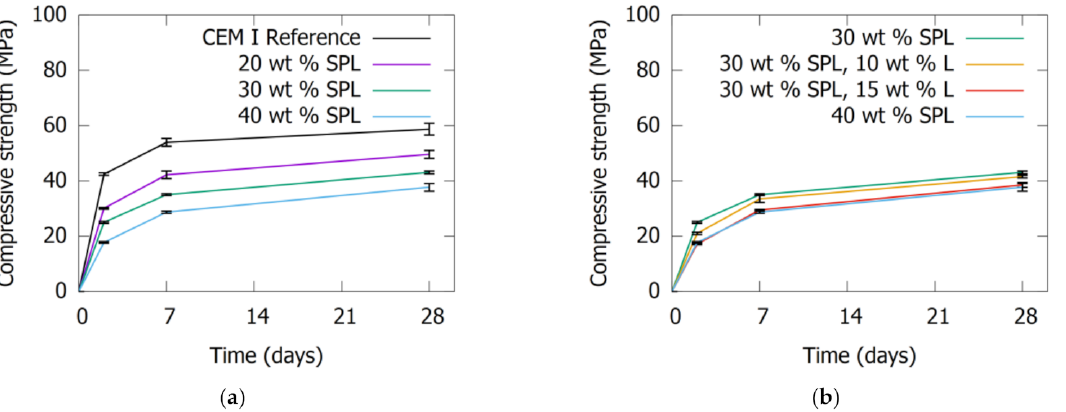
Figure 9. Compressive strength evolution of mortars using several replacement levels of spent pot lining aluminosilicates (SPL) as supplementary cementitious material ( a ). The influence of the addition of limestone (L) to mixtures with 30 wt% of SPL is shown in ( b